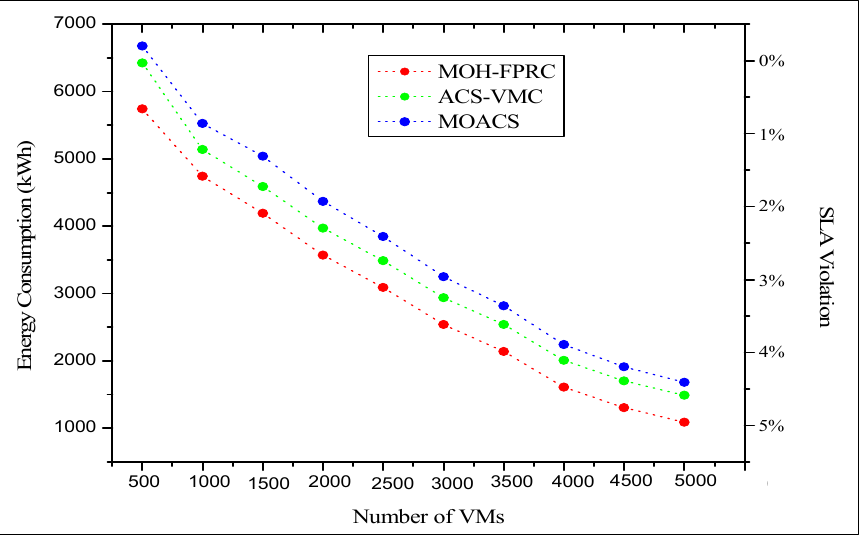
Figure 5. Comparison of algorithms Energy consumptions and SLA violation on VMs allocation.